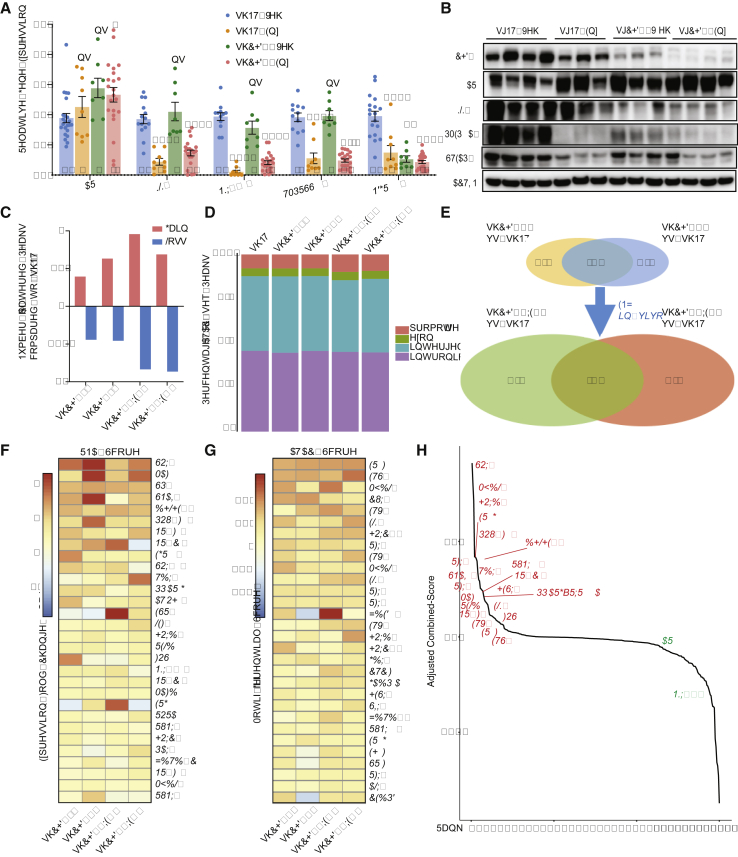
Integrated Analysis of RNA-seq and ATAC-Seq Reveals Candidate Transcription Factor Drivers of Enzalutamide Resistance(A) Relative gene expression of AR and AR target genes in tumors collected from LNCaP/AR xenografts, all normalized and compared with shNT + Veh group. Mean ± SEM is presented. p values were calculated using two-way ANOVA and numbers of biological replicates are presented. ∗∗∗∗p < 0.0001, ∗∗∗p < 0.001, ∗∗p < 0.01, ∗p < 0.05.(B) Western blot showing AR and AR targets in tumors collected from LNCaP/AR xenografts. For both (A) and (B), Enz denotes enzalutamide treatment at 10 mg/kg from day 1 of grafting. Veh denotes 0.5% CMC + 0.1% Tween 80.(C) Graphical representation of the ATAC-seq peaks changes (gain or loss) in cell lines compared with shNT.(D) The distribution of ATAC-seq peak locations in different genetic regions. For both (C) and (D), reads from three biological replicates were pooled to calculate the consensus peaks.(E) Venn diagram represents the overlap of the most differentially expressed genes in four groups compared with shNT. Cutoff values of fold change greater than 2 and false discovery rate ≤ 0. 1 were used. Reads from three biological replicates in each group were used for analysis.(F) Heatmap represents the expression fold changes (comparing to shNT) of the top 30 genes ranked by RNA-Score, three biological replicates in each group.(G) Heatmap represents the motif differential changes (compared with shNT) of the top 30 genes ranked by ATAC-Score, three biological replicates in each group.(H) Rank of candidate transcription factors (TFs) are shown based on the adjusted Combined-Score. Top candidate TFs selected for functional CRISPR library screen are presented in red.See also Figures S4 and S5 and Table S4.